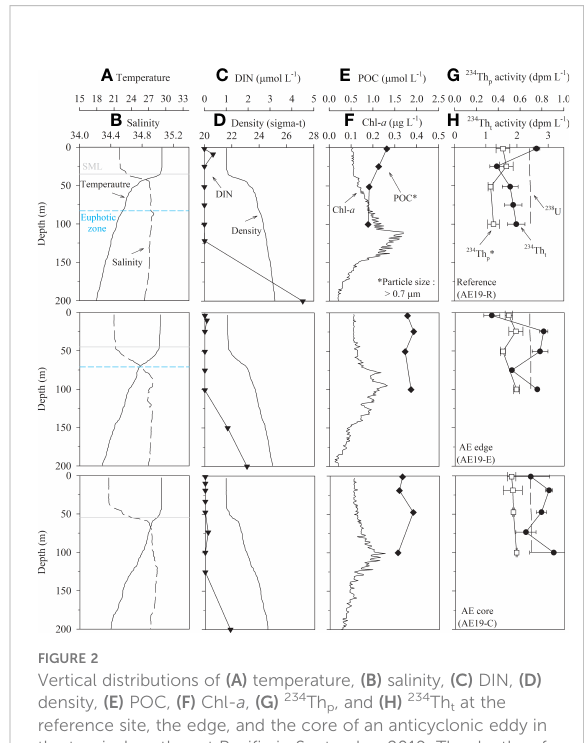
FIGURE 2 Vertical distributions of (A) temperature, (B) salinity, (C) DIN, (D) density, (E) POC, (F) Chl- a , (G) 234 Th p , and (H) 234 Th t at the reference site, the edge, and the core of an anticyclonic eddy in the tropical northwest Paci fi c in September 2019. The depths of SML (solid line) and euphotic zone (dashed line; 1% of PAR, photosynthetically active radiation) are denoted. The euphotic zone at AE19-C were not shown because PAR data are not available. Particle samples were > 0.7